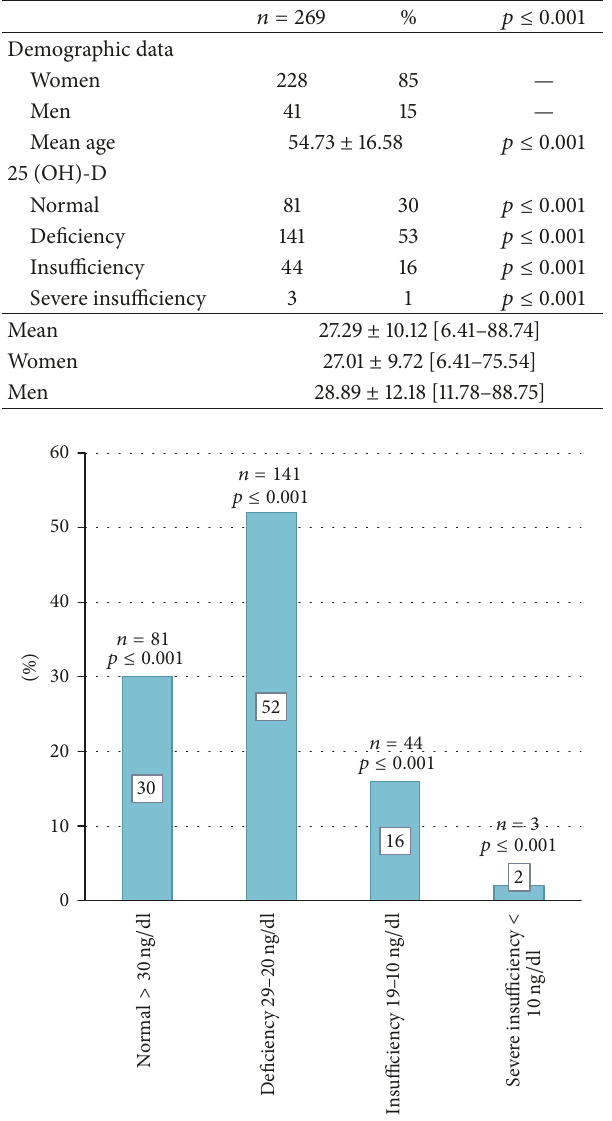
Table 2: Age groups.